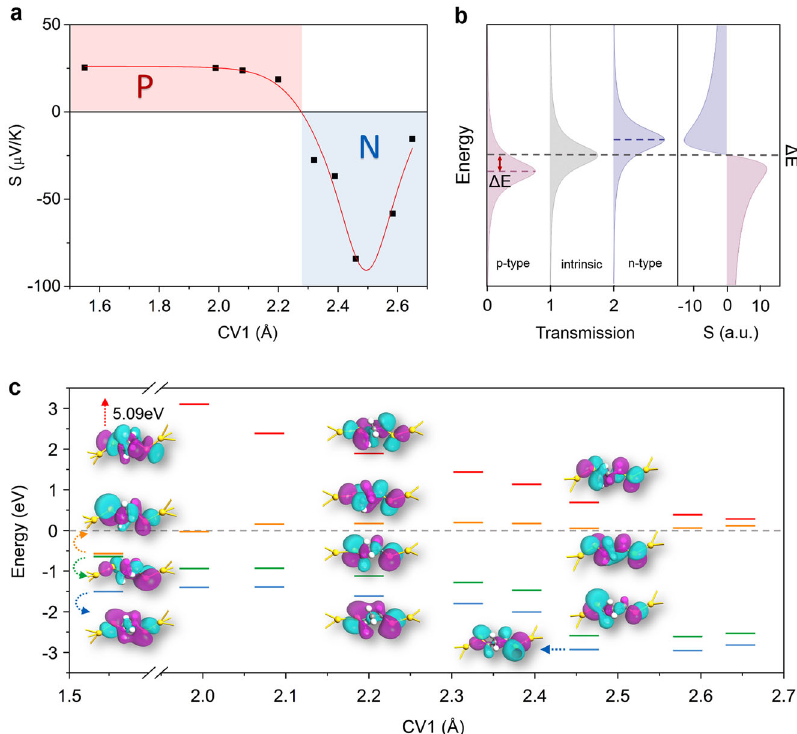
Fig. 3 Charge carriers transition and movement of energy levels in ring-opening reaction. a The thermopower changes during the CV1 (distance of C1 – C3) extends from 1.6 to 2.6 Å. The junction is p-type for positive thermopower and n-type for negative one. b Schematic illustration of transmission functions for only one energy level located beneath, on, and above Fermi level which correspond to p-type, neutral, and n-type respectively; on the right, the thermopower induced by an individual level for different Δ E = − ( E F − ε i ) from Eq. (3). c The molecular energy level alignment during CV1 extends from 2.0 to 2.6 Å. During the process, the isosurfaces of the orbitals are slightly extended. The gray dashed lines show the Fermi